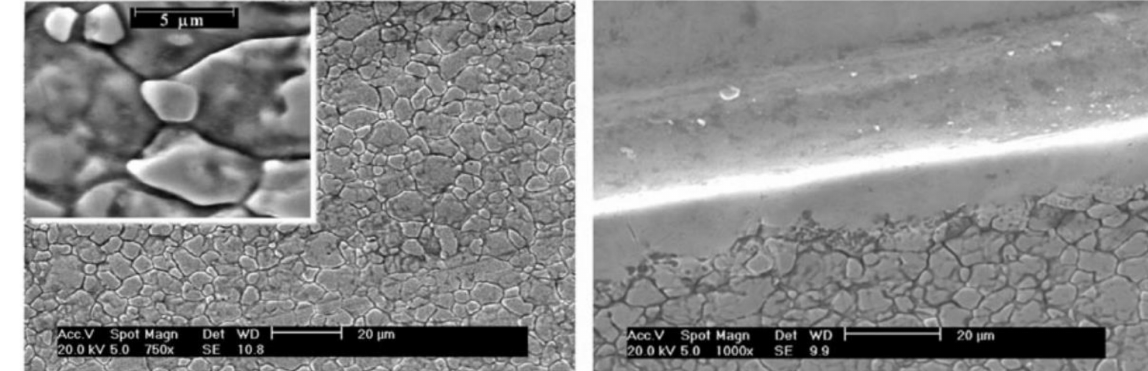
Figure 2. SEM image of the unpolished stainless steel 304 region ( left ) and SEM image of stainless steel 304 ( right ), showing transition between polished (top) and unpolished (bottom) regions of the sample after electrochemical polishing in a choline chloride–ethylene glycol mixture (reprinted with permission from ref. [36]; Copyright 2006 The Owner Societies).